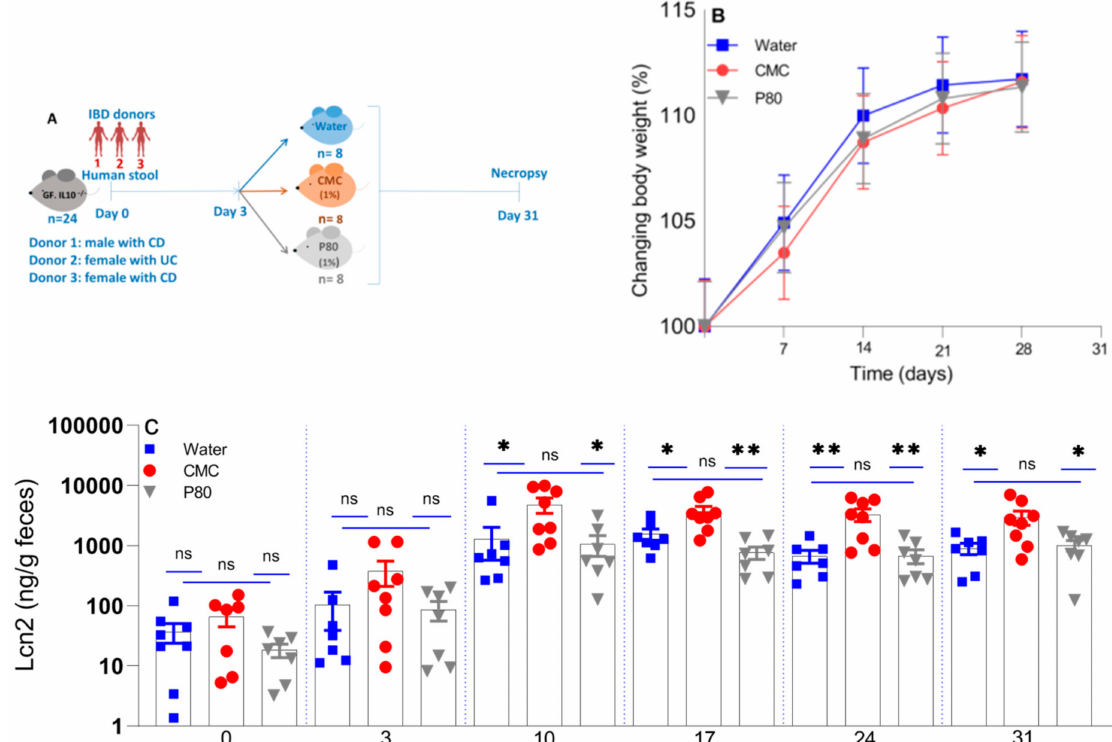
Figure 1. The impact of synthetic emulsifiers on body weight and an inflammatory fecal biomarker. In vivo experimental design ( A ), changes in body weight from baseline ( B ) and serial fecal Lcn-2 ( C ) in humanized IL10 − / − mice treated with CMC (1% w / v , red circle), P80 (1% v / v , gray triangle), and water (control, blue square). GF IL10 − / − mice were colonized with a pool of feces derived from three patients with active IBD and treated with water only, CMC (1% w / v ) or P80 (1% v / v ) in drinking water ad libitum for 31 days. The data are mean ± SEM of 7–8 individual mice. * p < 0.05; ** p < 0.01 by one-way ANOVA followed by Tukey multiple comparisons test. IBD; Inflammatory Bowel Diseases, CD; Crohn’s disease, UC; Ulcerative colitis, and ns; not